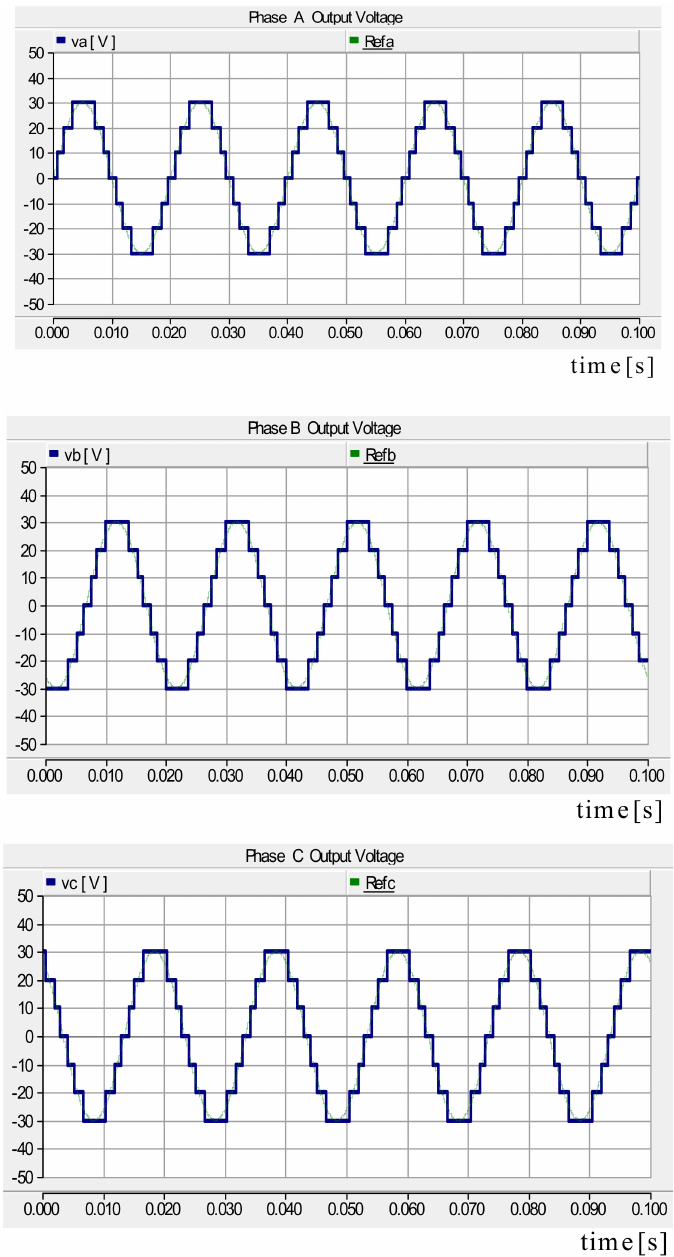
Figure 6. Phase output voltage